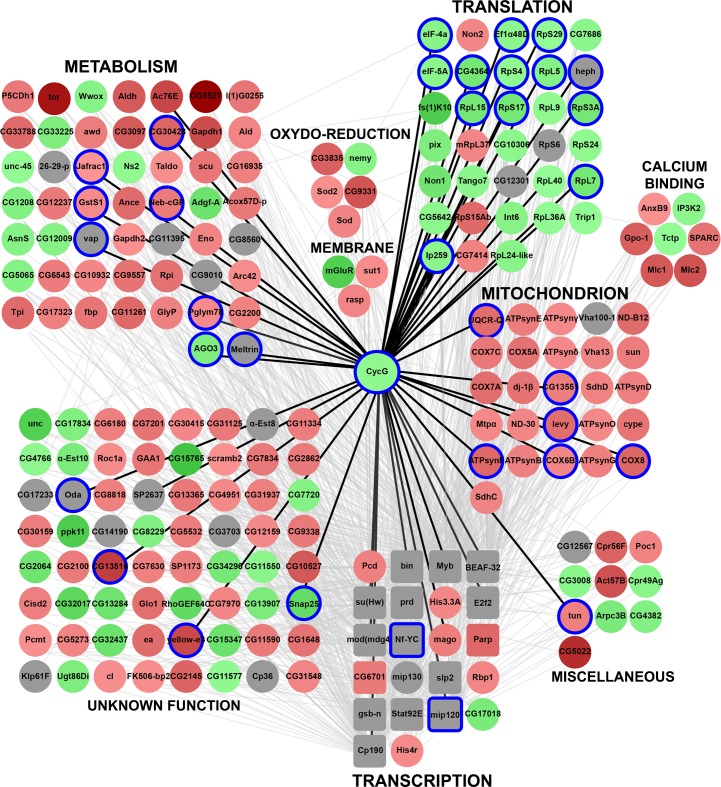
Functional subnetwork identified in wing imaginal discs expressing
CycGΔP.Schematic representation of a sub-network of 222 genes centred on Cyclin
G (CycG_subnetwork.xmml) and identified using JactiveModules (Z score
48.53). In this sub-network, 65 genes were up-regulated in
da-Gal4,
UAS-CycGΔP
vs da-Gal4/+ wing imaginal discs (green gradient), 124
genes were down-regulated (red gradient), and 33 genes were not
significantly deregulated (grey). Genes bound by Cyclin G are circled in
blue. Transcription factor genes are represented by squares. Genes were
clustered depending on their function. Black edges correspond to
interactions discovered in the present study. Grey edges correspond to
interactions described in the literature and imported into the WID
network using DroID.